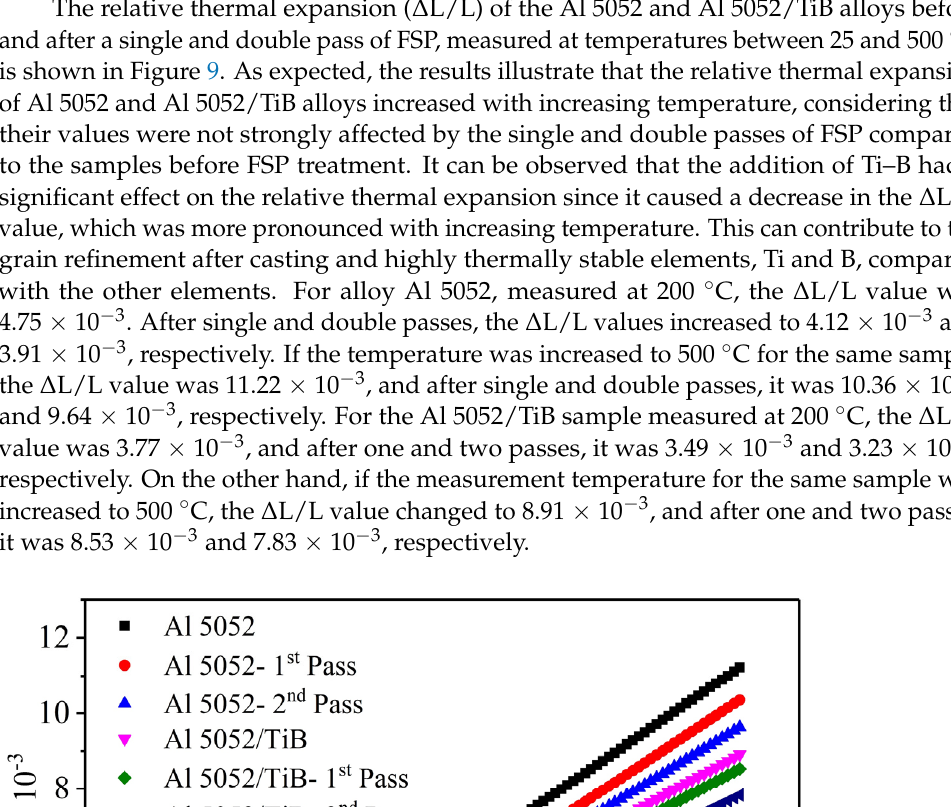
(CTE ≈ 7.1 × 10 − 6 / ◦ C) [38]. Moreover, residual stresses caused by thermal